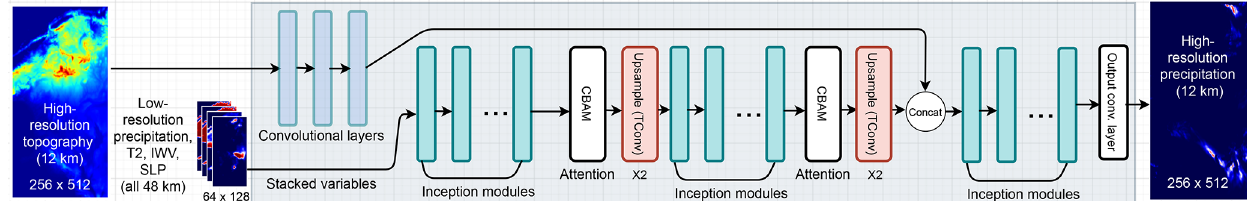
Figure 3. Model architecture for Direct-Simple and the generator of Direct-CGAN. CBAM: Convolutional Block Attention Module (Woo et al., 2018). TConv: Transposed convolution. The inception module is shown in Fig. 4.